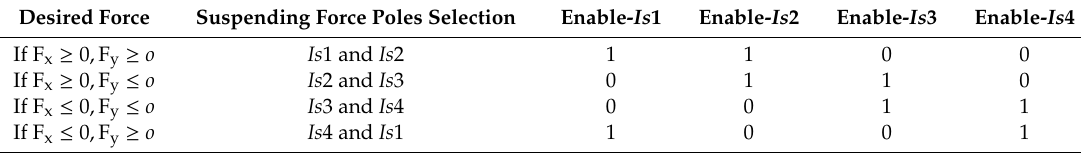
Table 3. Hysteresis current control switching states for BSRM.